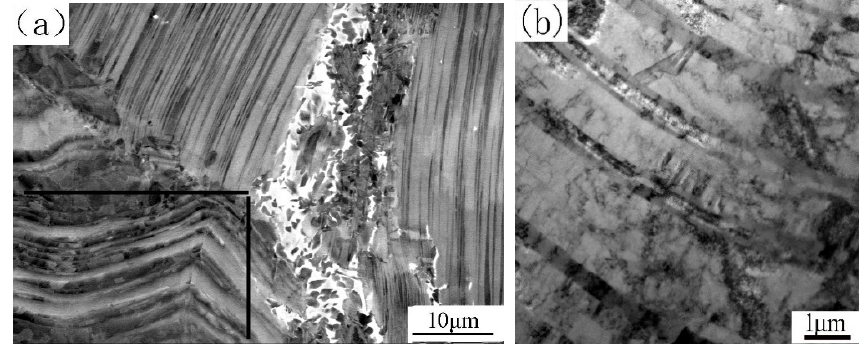
Figure 9. Microstructure of TZ near PM: ( a ) SEM-BSE image and ( b ) TEM image.